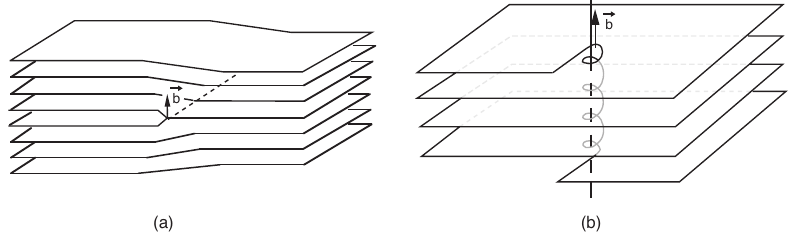
Figure 2. ( a ) edge dislocation; ( b ) screw dislocation.